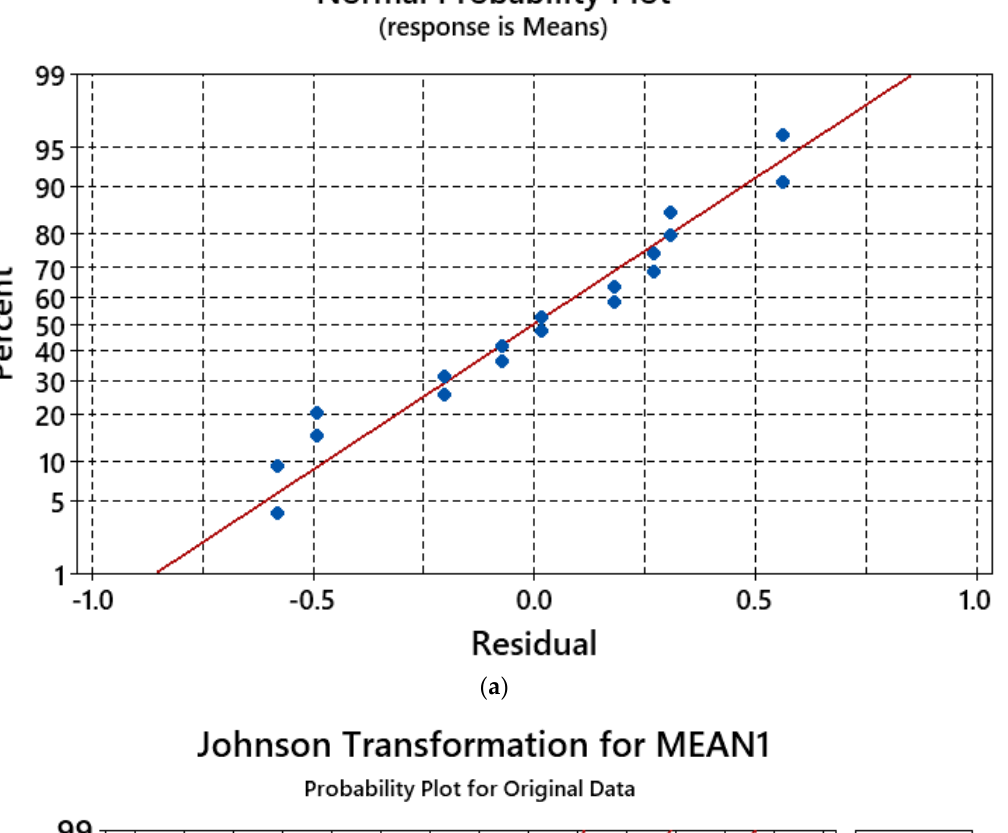
Table 5. ANOVA for 𝑅 (cid:3028) . Source